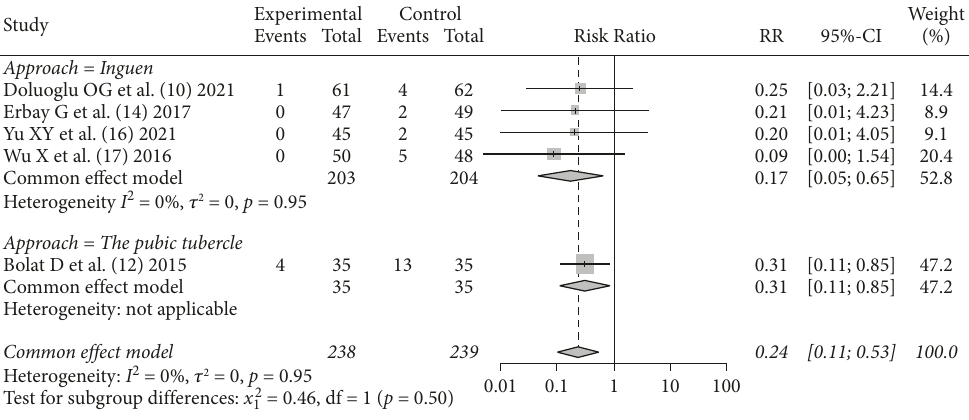
Figure 2: Comparison of the incidence of bladder perforation between SA +ONB and SA alone in TURBT.